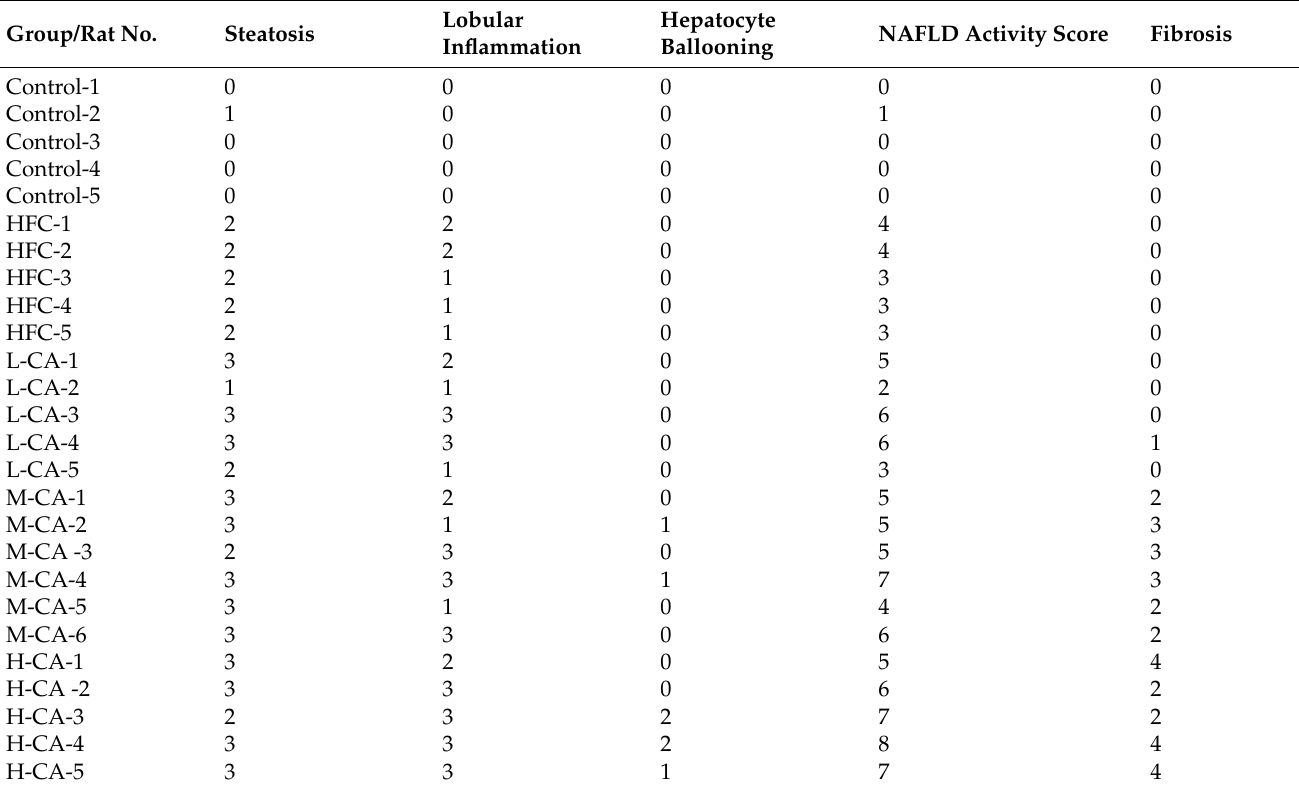
Table 2. Histopathological assessment of the liver in Sprague–Dawley rats fed the normal, HFC or CA-supplemented HFC diet for 9